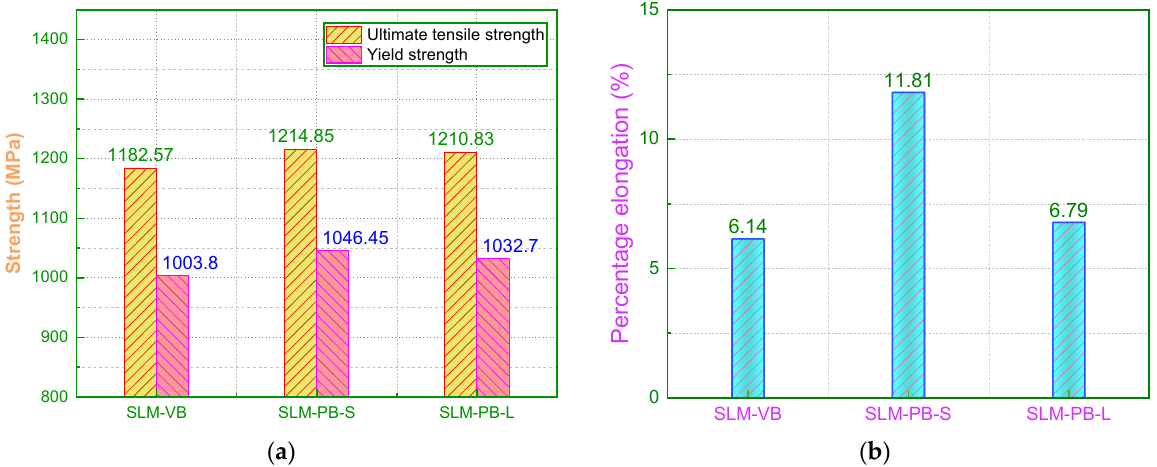
Figure 9. Results of tensile properties for SLM Ti6Al4V samples. ( a ) Ultimate tensile strength and yield strength data; ( b ) percentage elongation data.